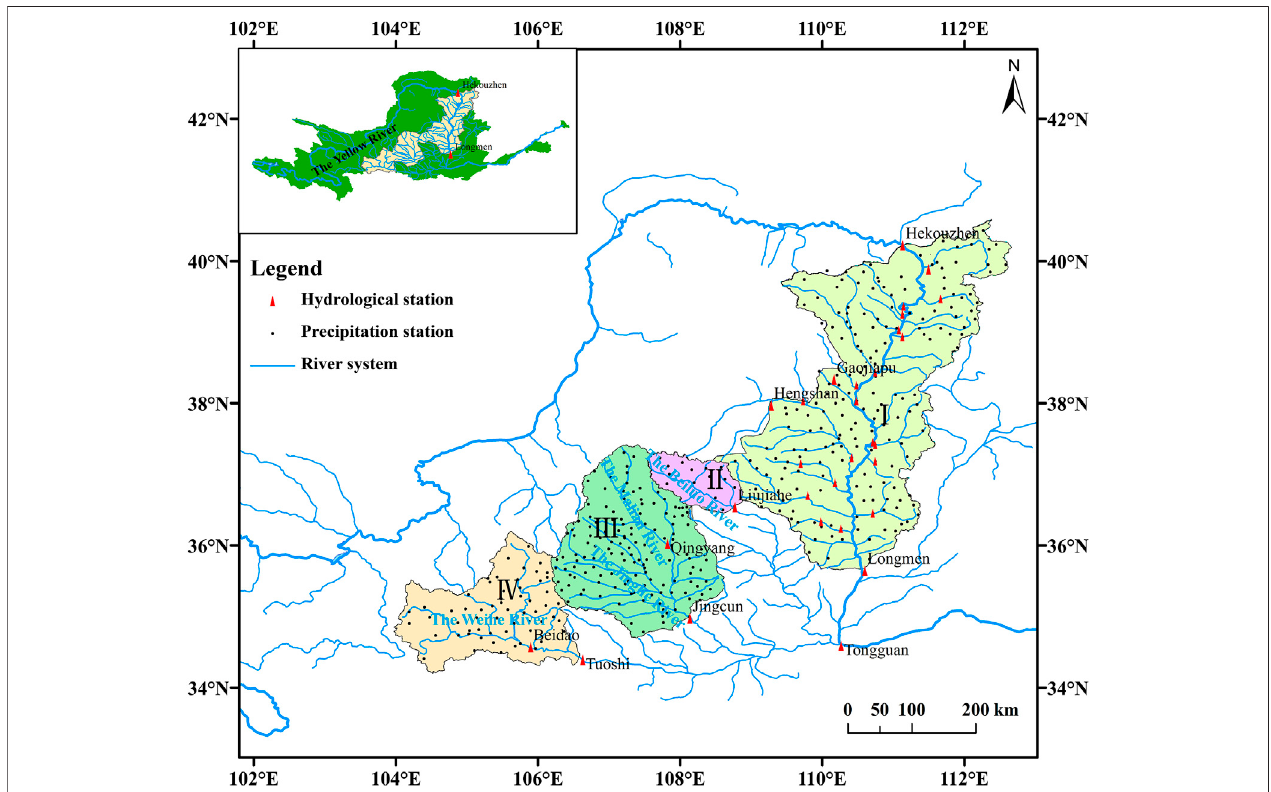
FIGURE1| Sketchmapofthestudyarea:I.HLR(excludingthesandyareaintheupperreachesoftheWudingRiverBasinandTuweiRiverBasin);II.BLR;III.JHR; and IV. WHR.